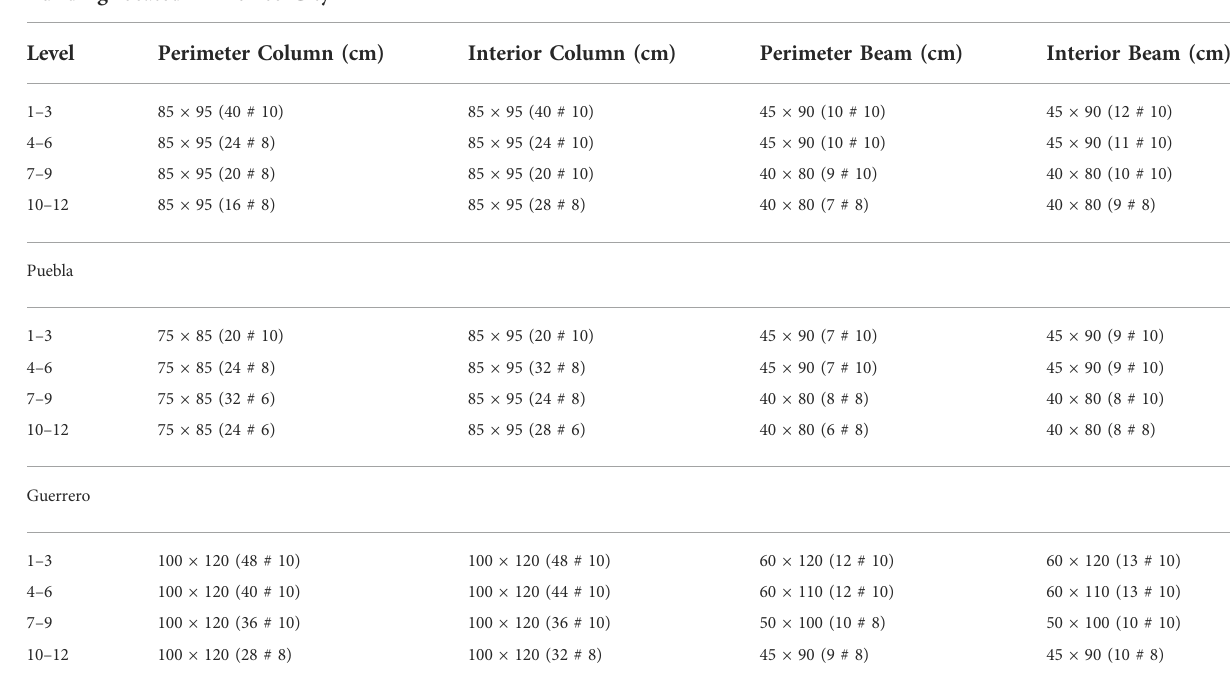
TABLE 2 Dimensions of beams and columns used in each storey for the designed